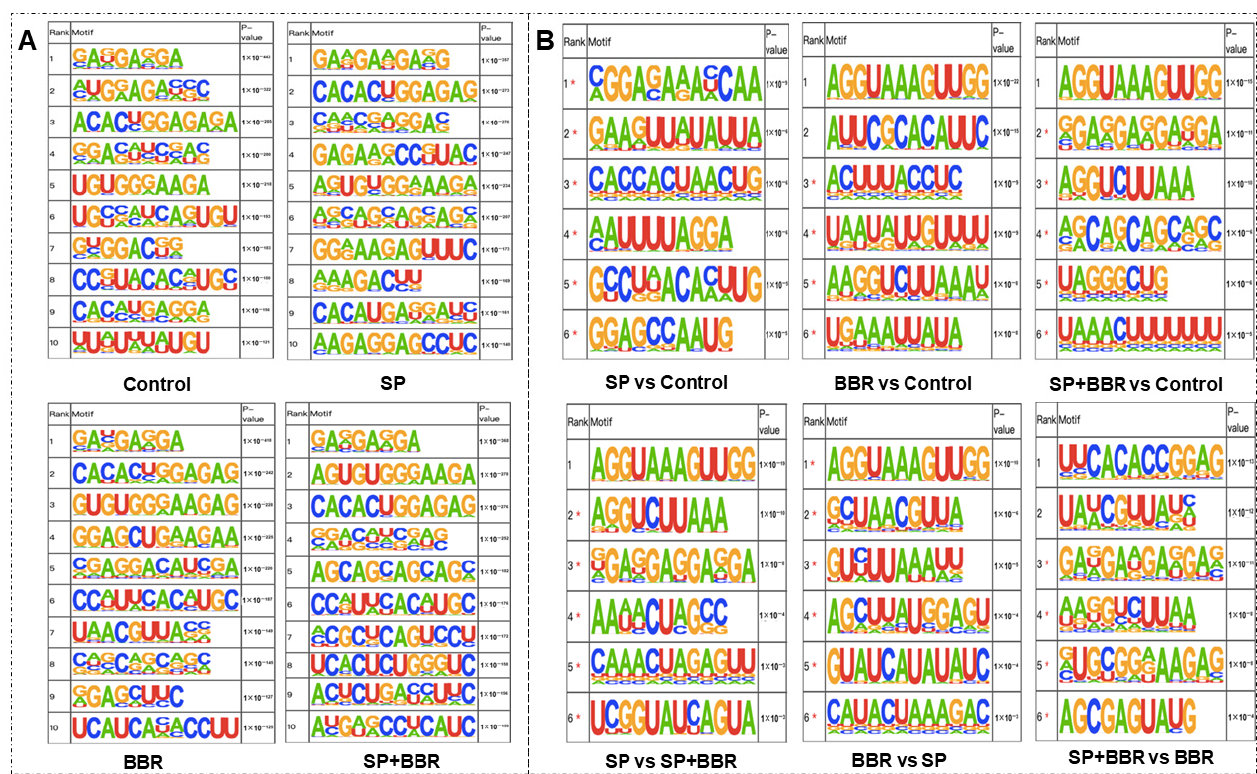
Figure 3. Distribution of m6A peaks of each group within ZFL.